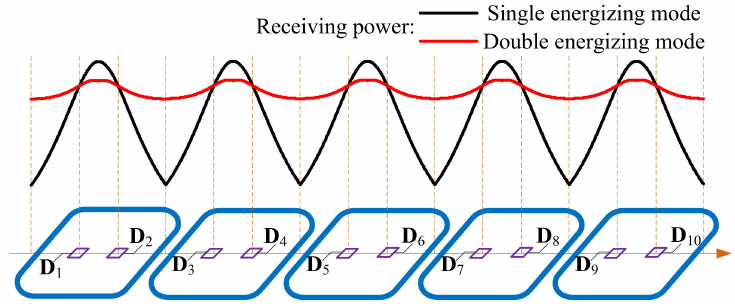
Figure 9. The multiple detection positions of switching